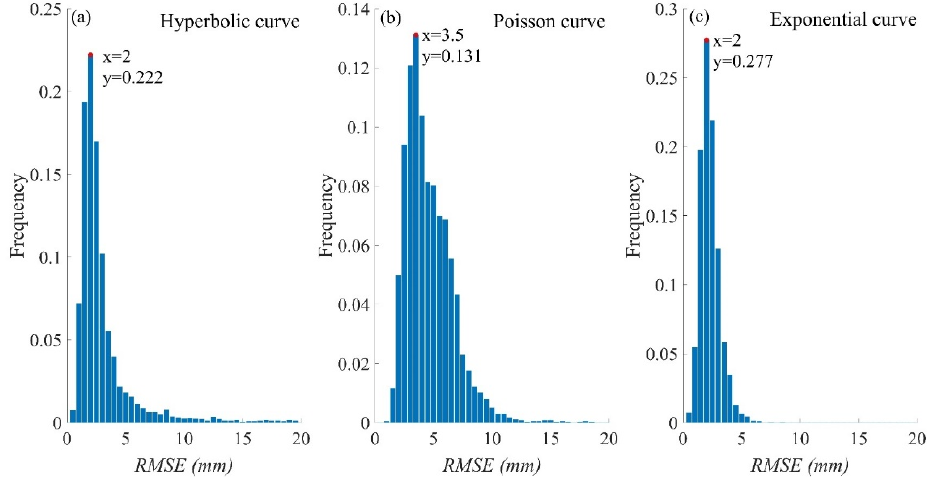
Figure 9. RMSE of ( a ) Hyperbolic curve fitting, ( b ) Poisson curve fitting and ( c ) Exponential curve fitting.